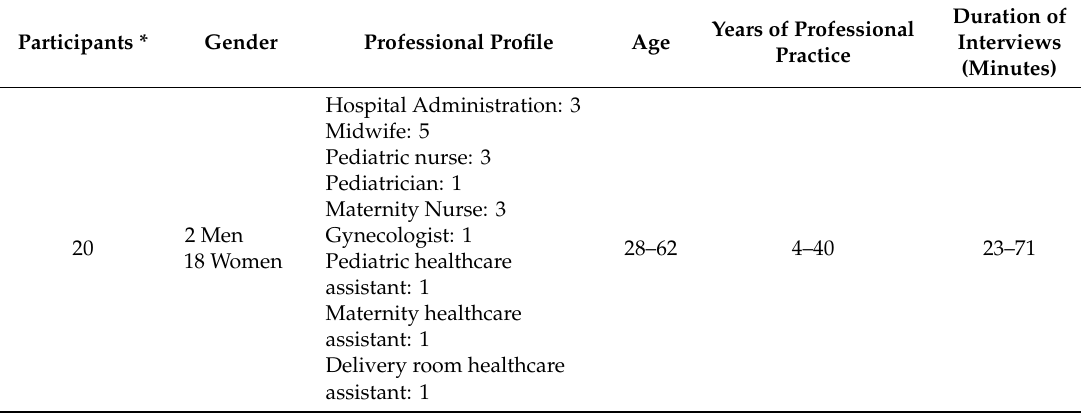
Table 1. Characteristics of the participants and duration of the interviews.